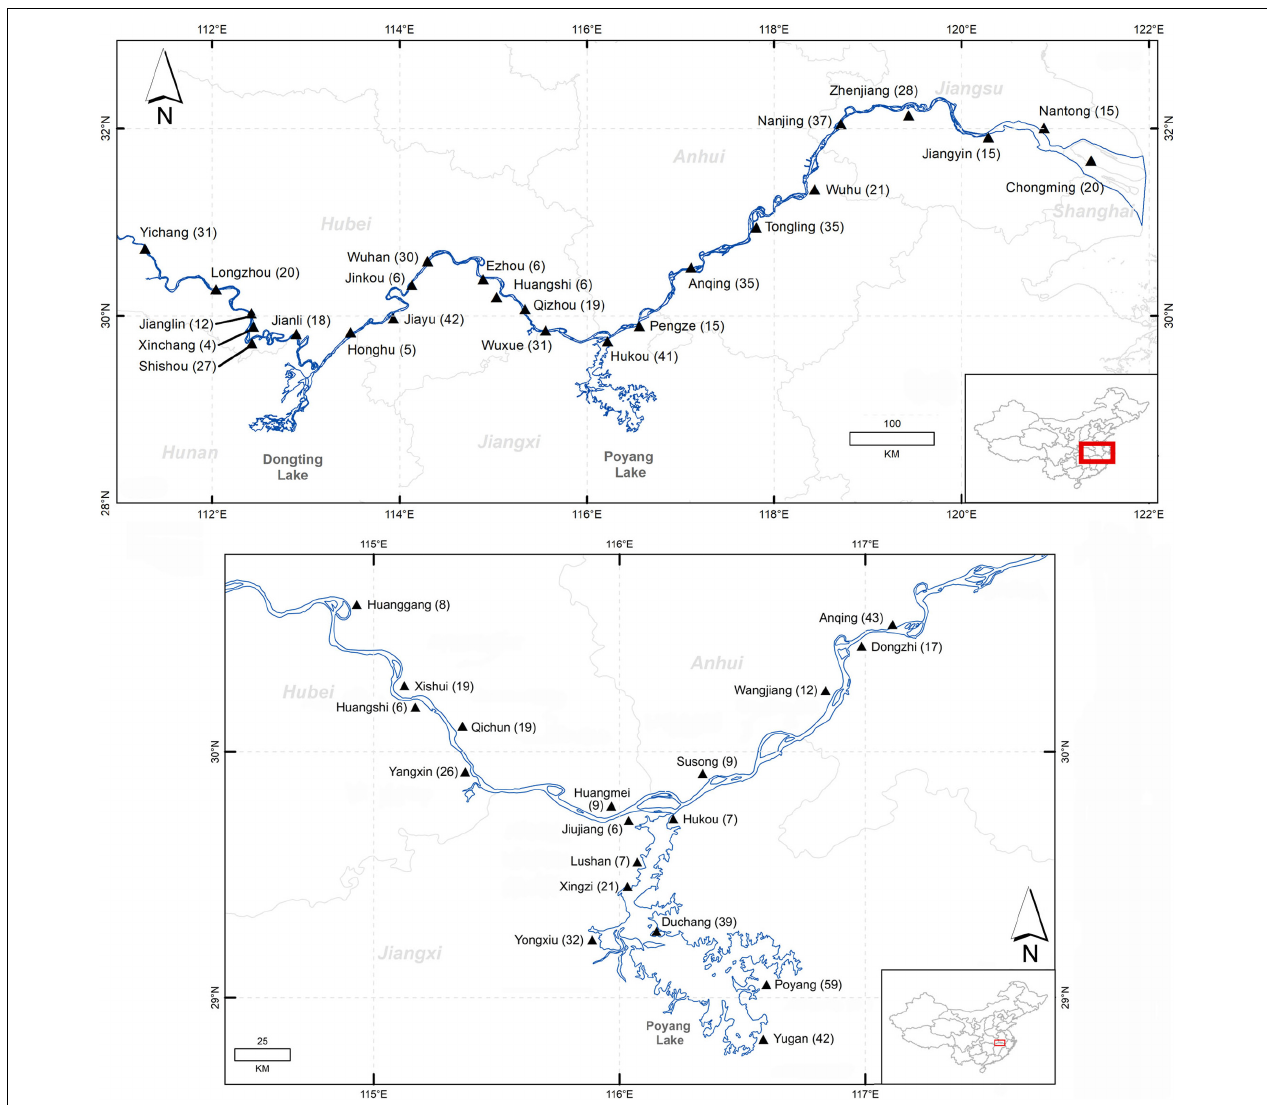
FIGURE 1 | (Top) Middle-lower Yangtze drainage (Yichang-Shanghai), showing 2008 fisher survey localities and number of interviews. (Bottom) 2011–2012 fisher survey localities and number of